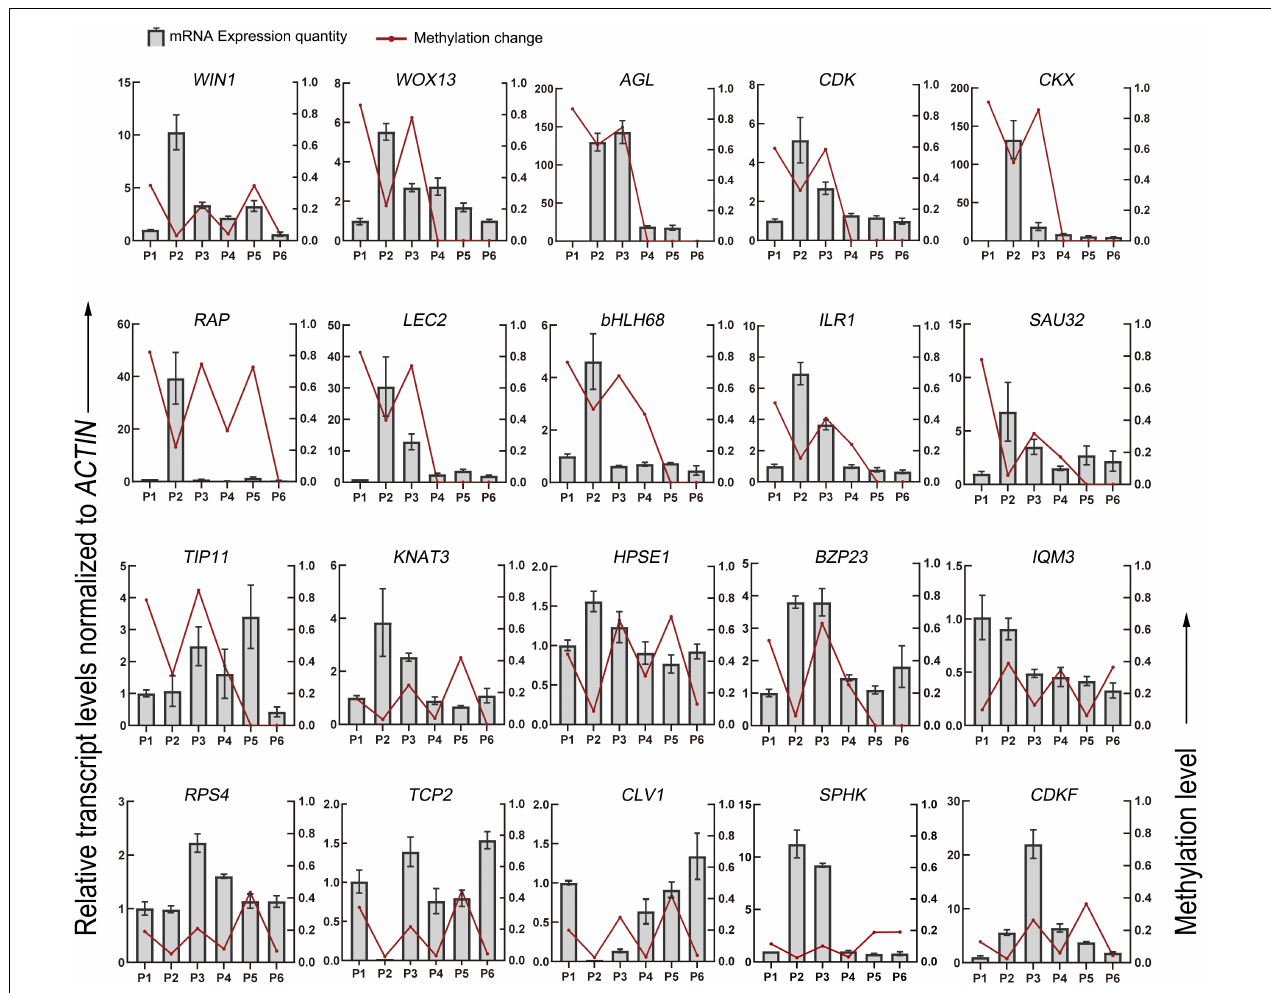
FIGURE 6 | DNA methylation level and gene expression level of DMGs detected in the different stages of tissue culture of F. nilgerrensis . The gene expression level was validated by real-time quantitative PCR. The ACTIN gene was used as an internal control to standardize the expression of different samples.